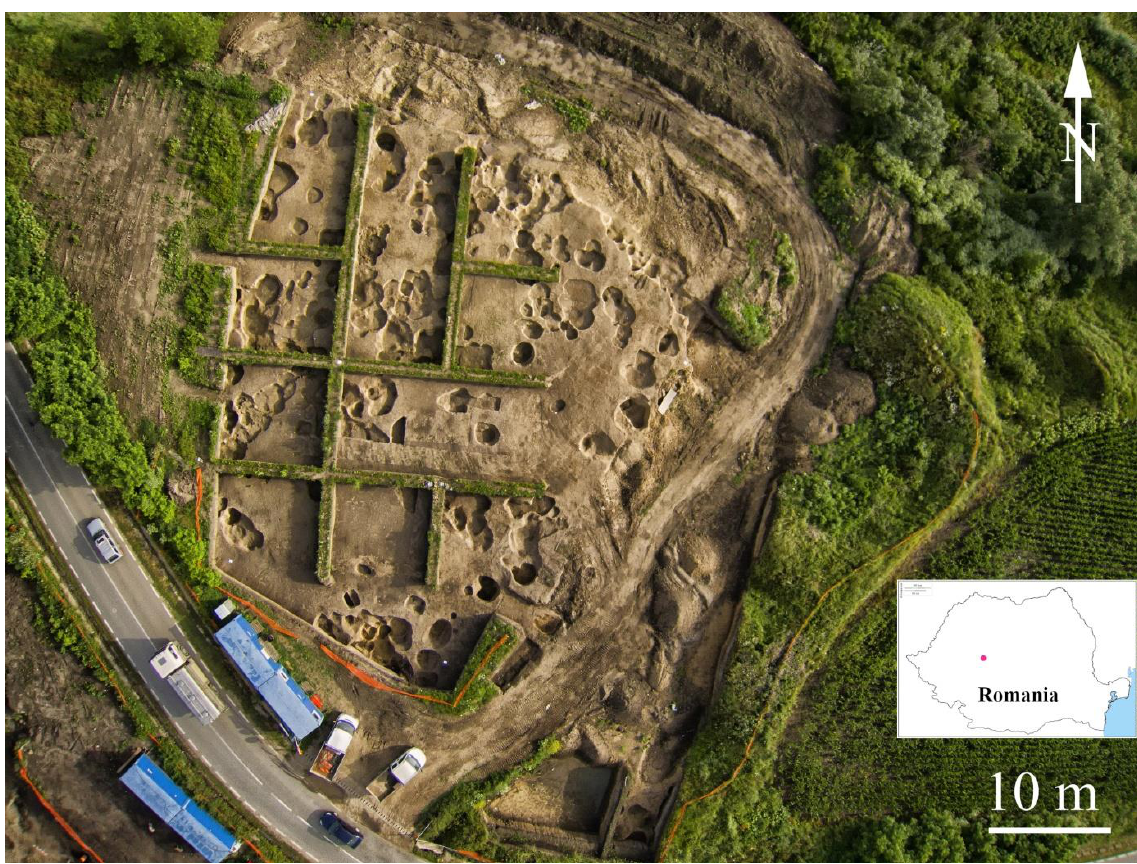
Fig. 2. Aerial view of the 2016 archaeological excavations at Limba-Oarda de Jos (Photo: M.M. Ciutǎ; image from Ciutǎ et al. 2016). The inset in the lower right shows the position of the area within Romania (modified from D-maps.com (2019)).